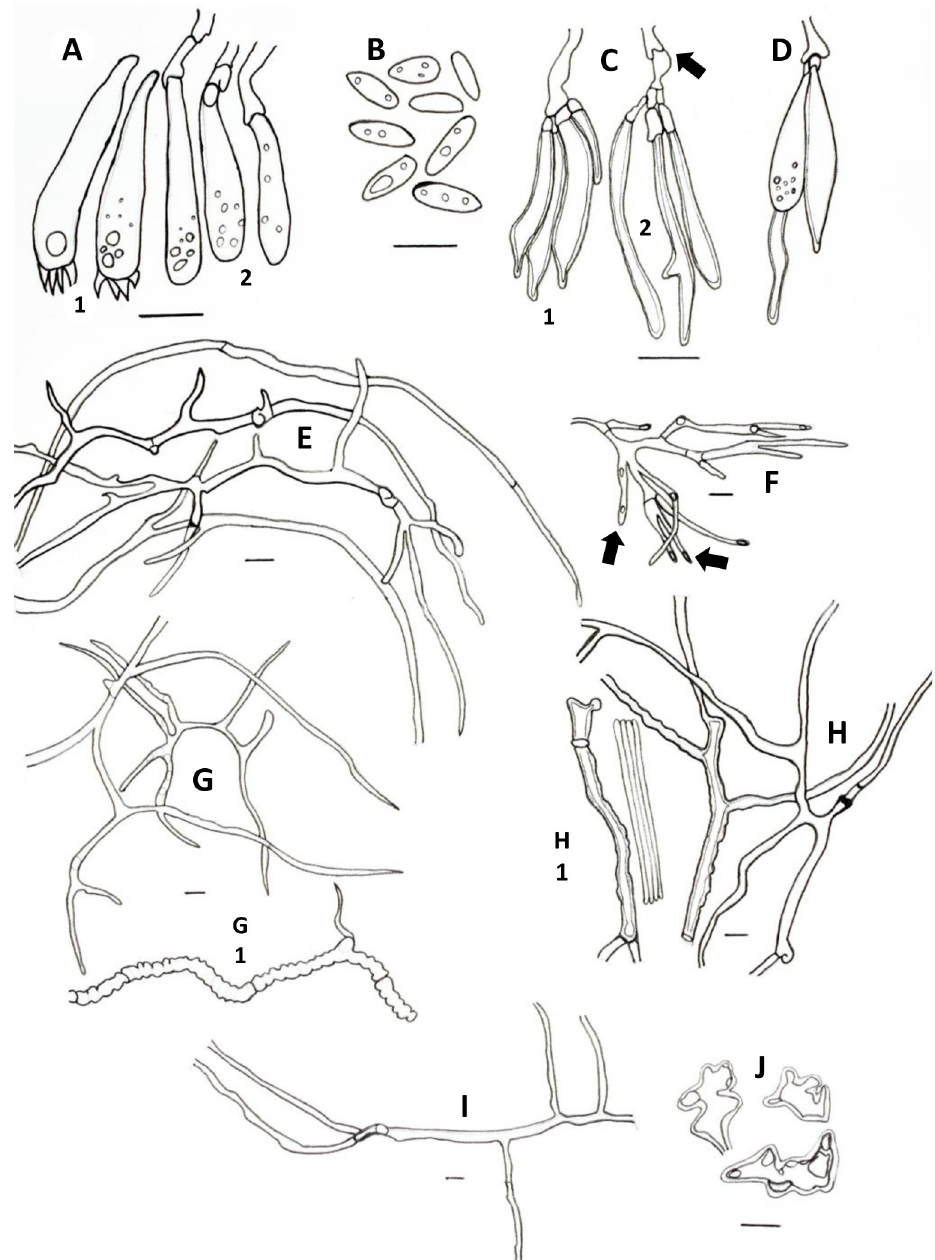
Fig 16. Microscopical features of P . taromenane . A. Basidia (1) and basidioles (2). B. Basidiospores. C. Paraphysoids structures. C1 Cystidioles of the ventricose type and C2 Hyphidia (arrow pointing a clamp connection). D. Basidiole, cystidiole of the ventricose type and hyphidia on a generative hypha. E-F. Hyphae from trama, with E. slightly ramified sections of thin-walled hyphae and F. Section of hyphae highly nucleated and highly ramified (arrows pointing on nucleus). G. Skeletal-binding hyphae from context . G.1. Plectenchymatous thickenings from context. H. Skeletal- binding hyphae from stipe. H.1. Plectenchymatous thickenings from stipe. I. Skeletal-binding hyphae from rhizomorphs. J. Individual cuticle cells from stipe. Scale bars = 10 μ m.